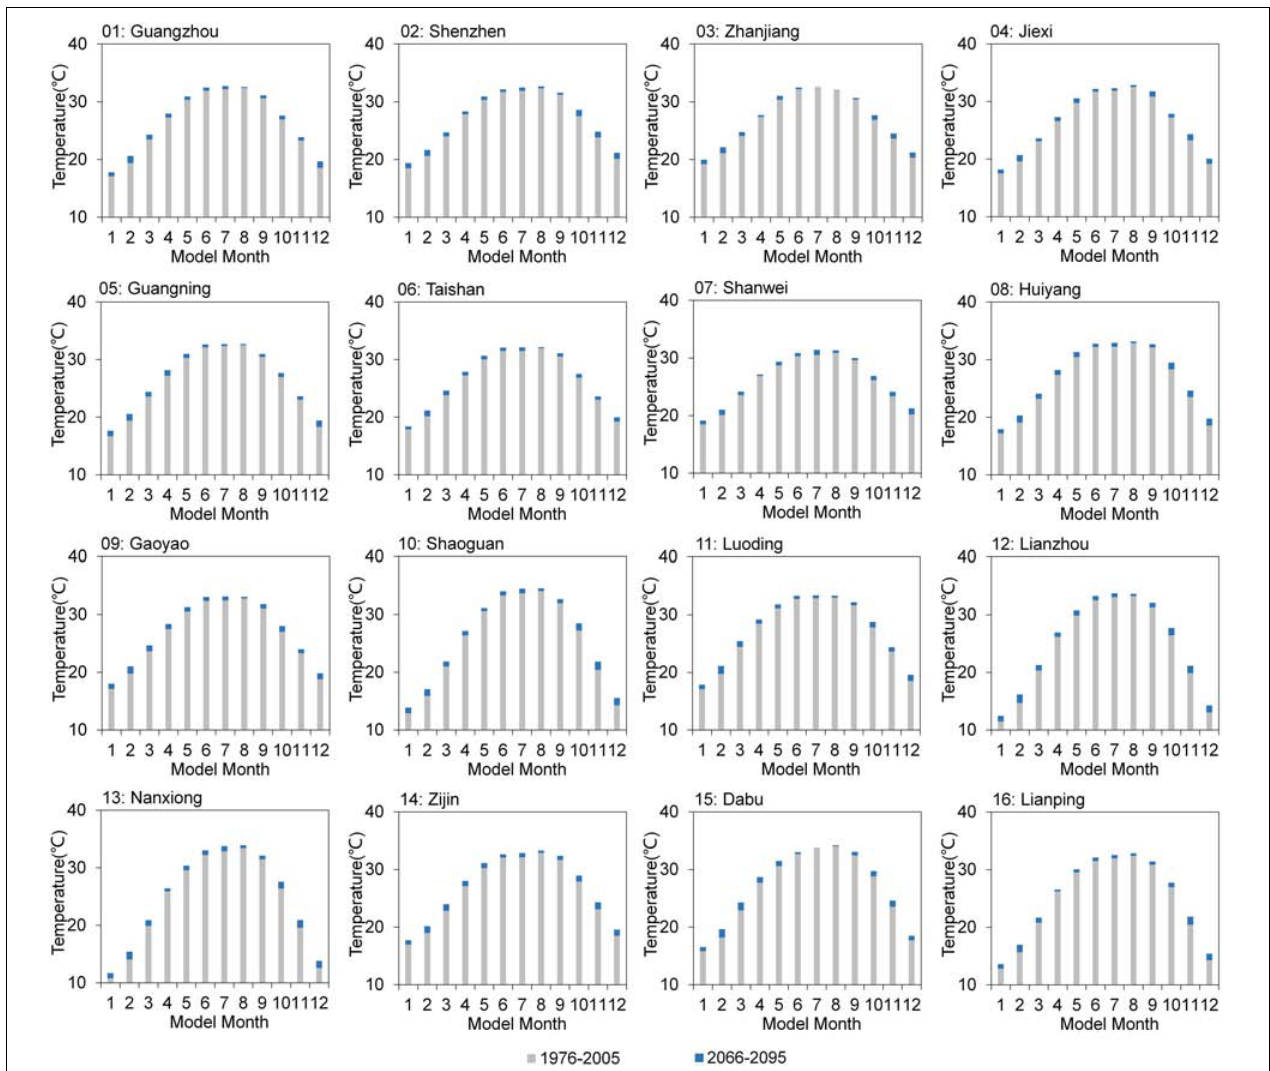
FIGURE 8 | Projected monthly variations of Tmax between 2066–2095 and 1976–2005 under RCP4.5.